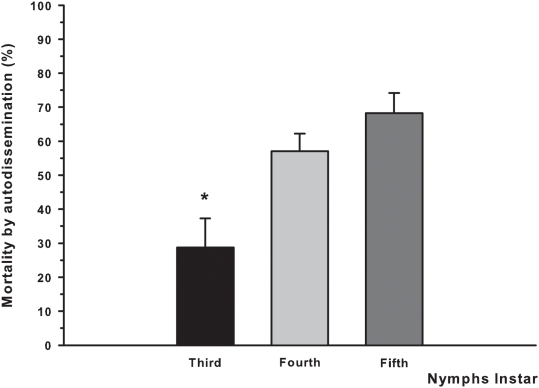
Horizontal transmission (autodissemination) of conidia from previously contaminated nymphs to initially non-infected nymphs.Three replicates were performed per experiment, and the experiment was repeated three times at bimonthly periods. The asterisk show significant differences (P<0.05). At the end of the experiment, only 3.7% of the fungus-treated survivors were able to molt, whereas 28.2% of the control bugs did molt.